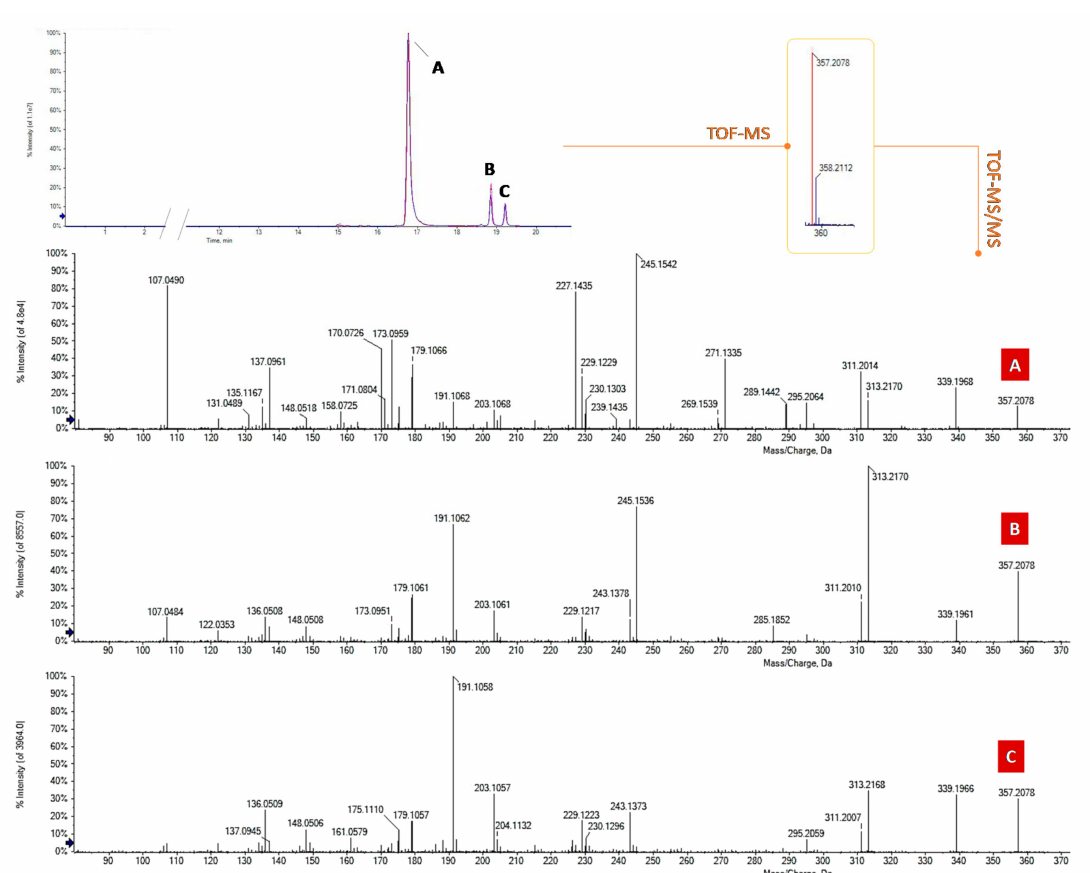
Figure 1. Overlapped XICs (extracted ion chromatograms) of the acidic phytocannabinoids at m / z 357.20 ± 0.025 in the three co ff ee drinks investigated and their TOF-MS 2 spectra. ( A ) Cannabidiolic acid (CBDA); ( B ) ∆ 9 -Tetrahydrocannabinolic acid (THCA-A); ( C ) Cannabichromenic acid